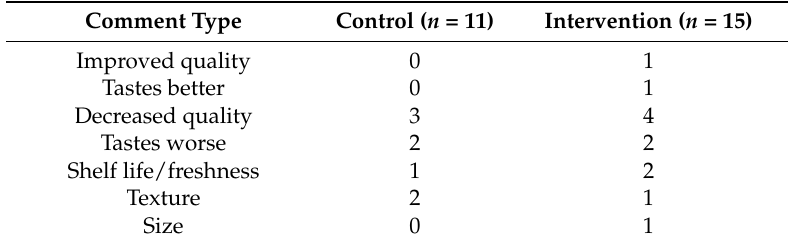
Table 4. Number of stores in each group where customers or store managers made comments related to quality of study